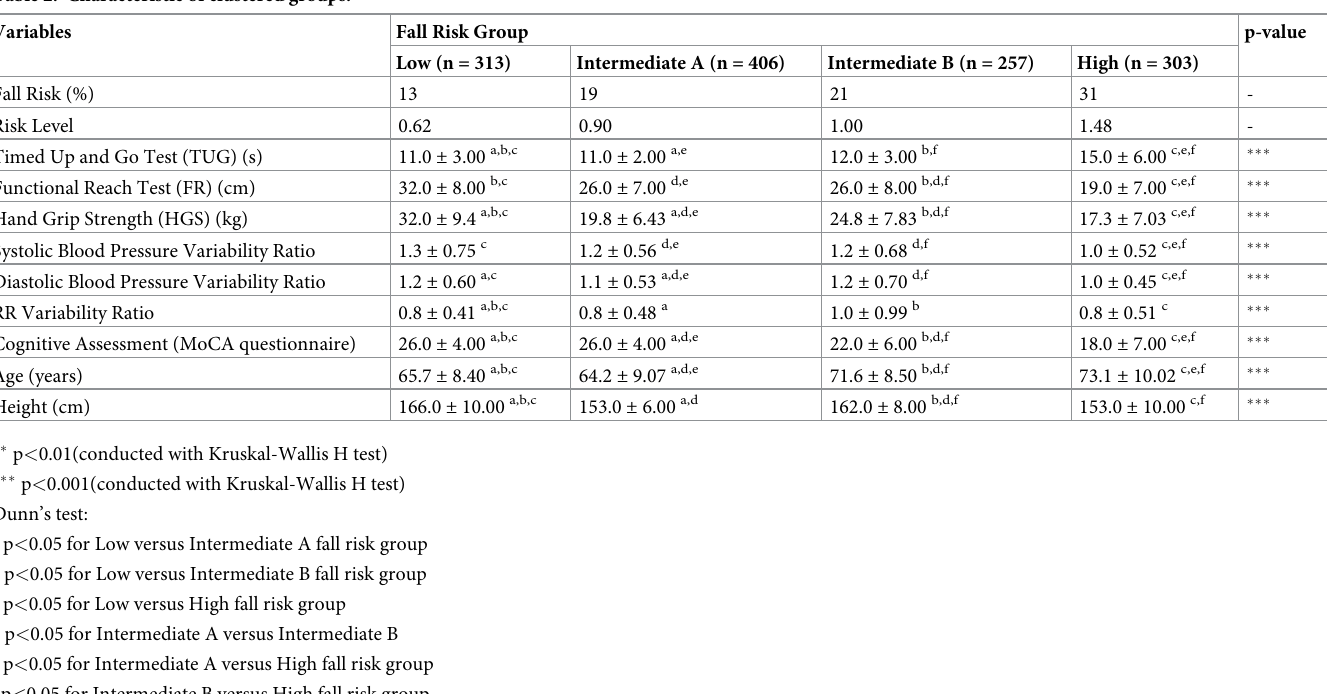
Table 2. Characteristic of clustered